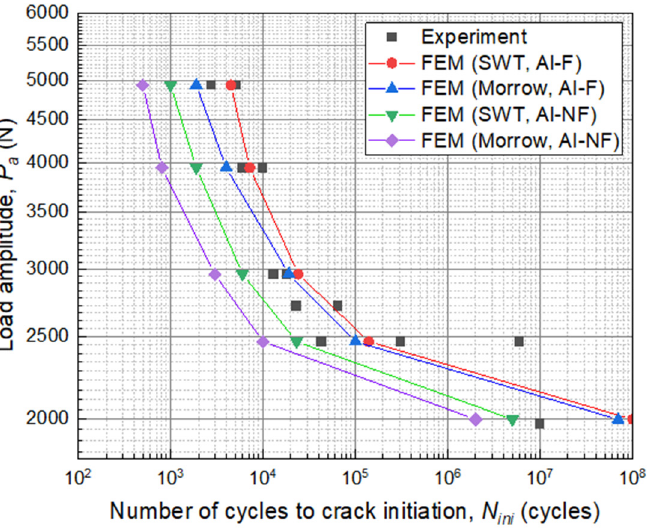
Figure 12. ( a ) Failed C-specimen after the fatigue test; ( b ) damage fraction contour of the FEM model; and ( c ) deformation of the FEM model.